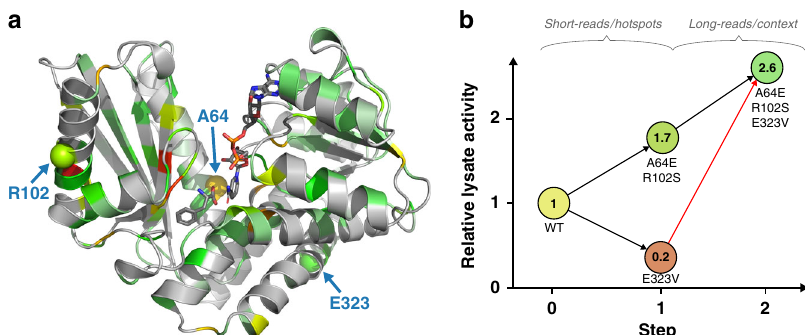
Fig. 4 Analysis of epistasis in variant A64E R102S E323V. a Hot-spot analysis. Positional enrichments mapped onto the structure of a homologous AmDH (PDB ID: 1C1D). If the frequency of mutation at a certain position increased over the rounds of directed evolution, its enrichment factor is color coded on the structure from green (low) to yellow to red (high). Enrichment was calculated from round 1 to round 2 for variants that persist into round 3. Positions at which mutations are enriched can be identi fi ed over the full range of the enzyme, with many enriched positions e.g. in the loop covering the substrate binding pocket. Positions exhibiting epistatic interaction (variant A64E R102S E323V) are highlighted. b Sign epistasis in variant A64E R102S E323V detected by long-read sequencing. Graph showing lysate deamination activities (initial rates) of constituent variants relative to the non-mutated parent. Sign epistasis can be seen in mutations of one founder variant (A64E R102S E323V). The mutation E323V individually decreases activity drastically (16% of the parental AmDH (WT) lysate deamination activity, Supplementary Fig. 5), while it has a bene fi cial impact when introduced into the variant A64E R102S (154% of A64E R102S lysate deamination activity). With conventional short-read sequencing for hot-spot analysis, E323V would have wrongly been determined as an activating mutation; yet E323V is only bene fi cial in the context of other mutations, which was correctly detected by long- read sequencing. Table 1 Characterization of A64E R102S E323V core set of mutations. Variant